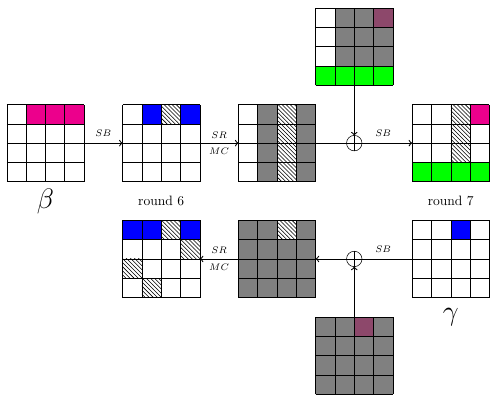
Figure 13: The middle two rounds of the boomerang attack against full AES -192 in Section 5.2. The differences of the bytes marked with slash are not